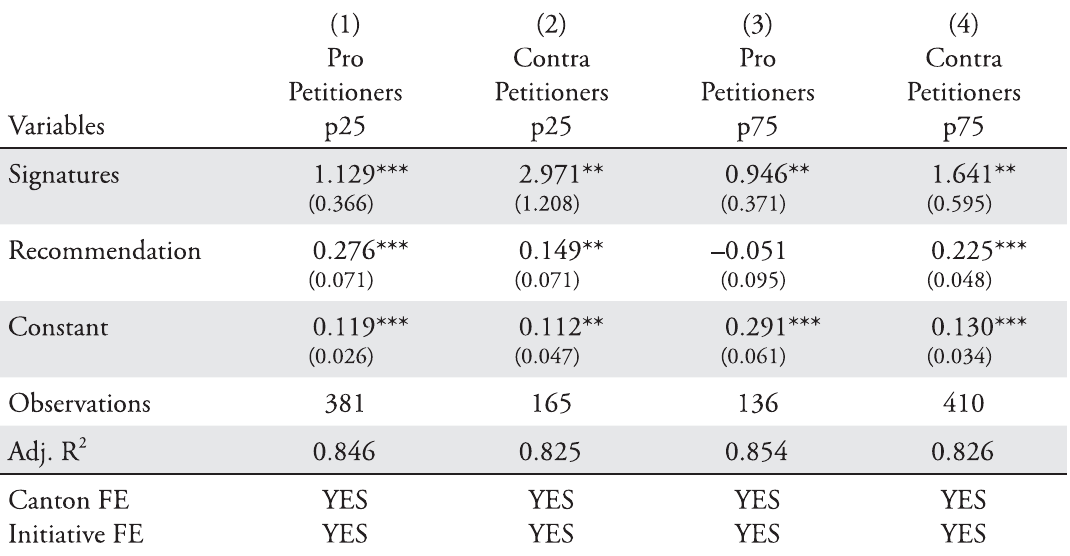
Table 7: Preferences Proxies: Party Recommendations-